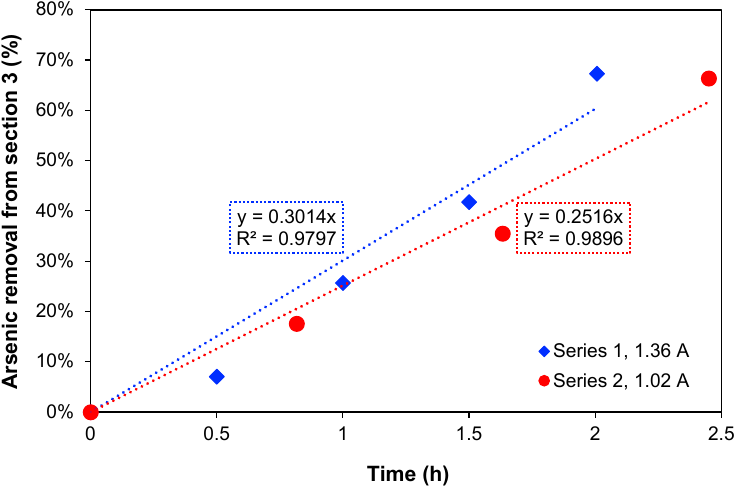
Figure 2. Percentage (%) of arsenic removal from Section 3 over time for the two series of currents.